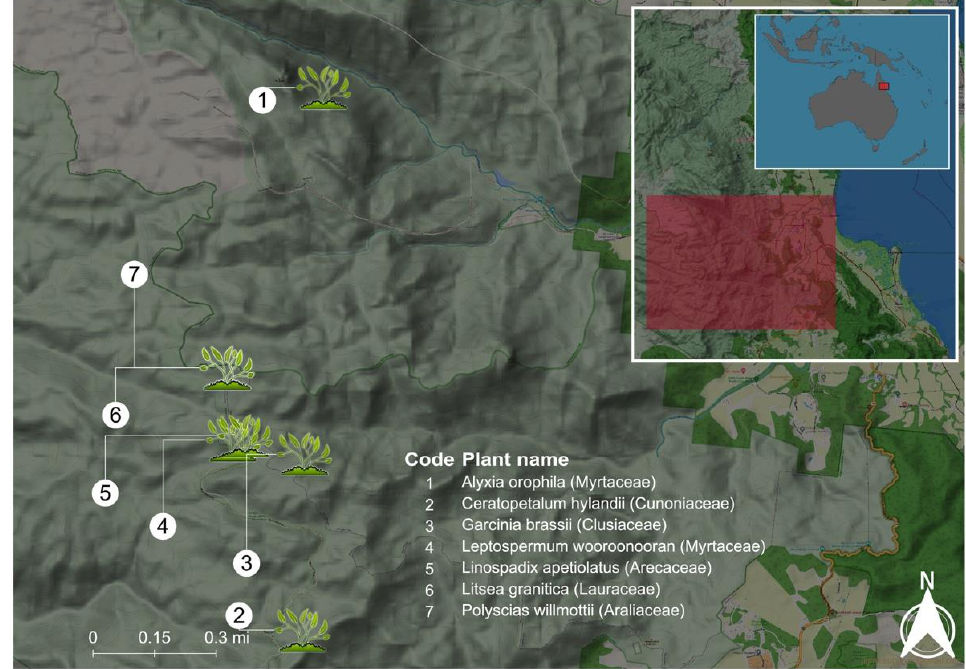
Figure 4. A map showing the collecti on sites of seven Wet Tropics’ mountaintop plants studied